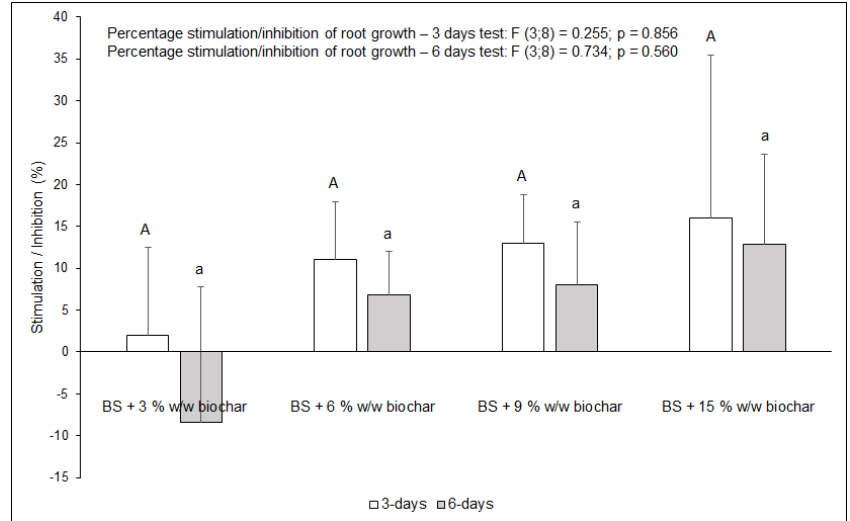
Figure 10. Comparison of inhibition/stimulation of root growth of Lepidium Sativum L. after 3 and 6 days of exposure to burnt soil supplemented with biochar in increasing proportions (compared to burnt soil). Average values (n = 3) + SE are presented, different uppercase letters indicate significant differences between individual variants after 3 days of testing and small letters after 6 days (one ‐ way ANOVA with post hoc Tukey’s HSD test). The results of the F test are shown at the top of the graph.